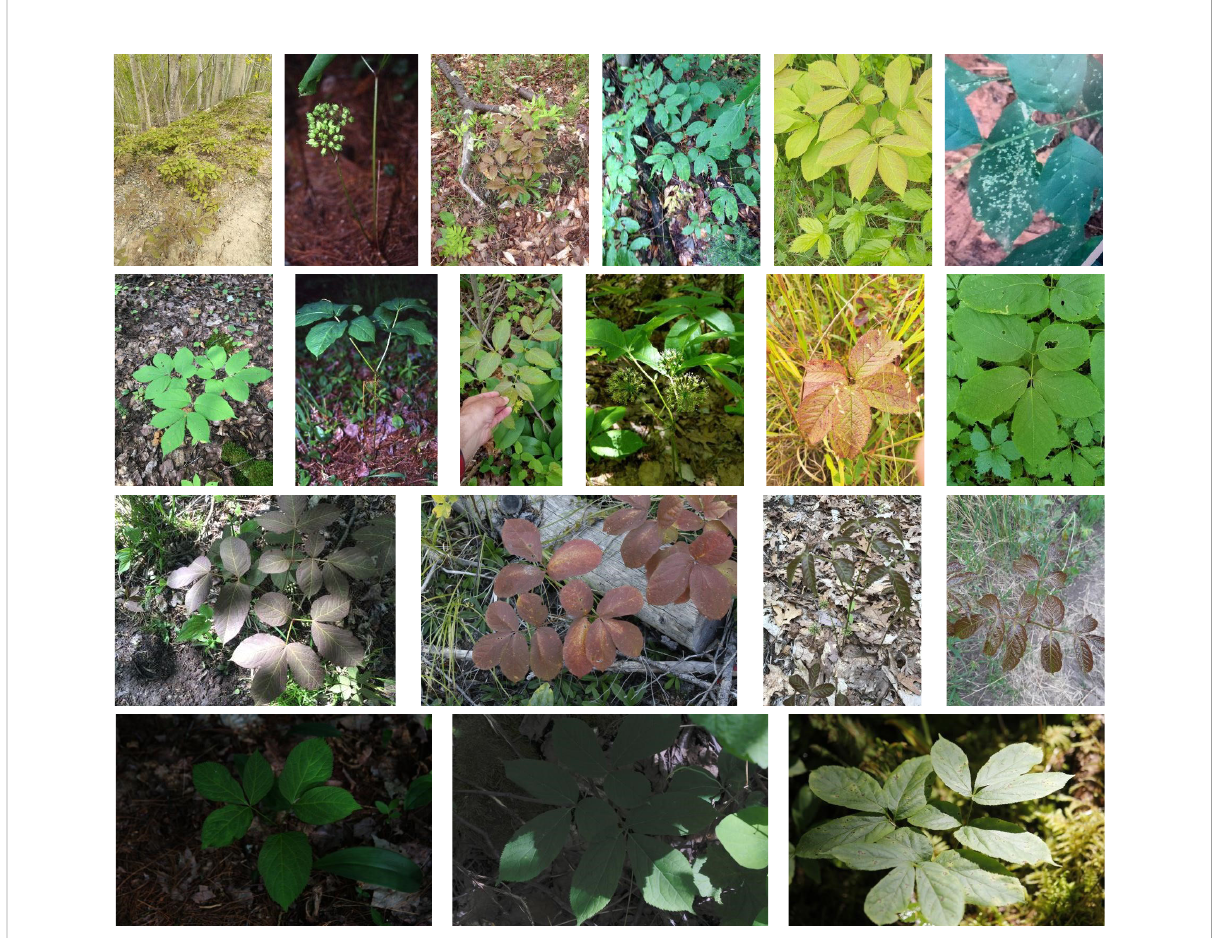
FIGURE 4 Images of Aralia Nudicaulis L. species from PlantCLEF2022 dataset. The images from the same plant species are heterogeneous in the background, illumination, color, scale,